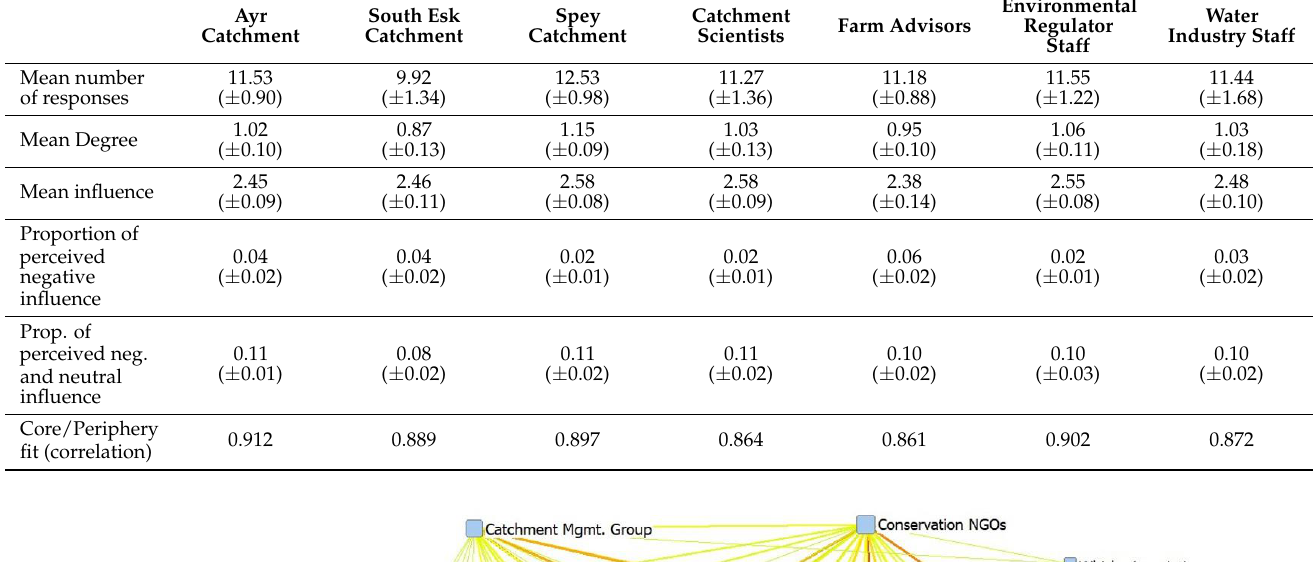
Table 1. Mean number of responses, mean degree, perceived influence, and proportion of perceived negative influence and negative and neutral influence of the three contrasting catchments and four key water management stakeholders ( ± 1 standard error). None of these statistics were significantly different between catchments or stakeholder groups (significance of differences between the means at 0.05 level).